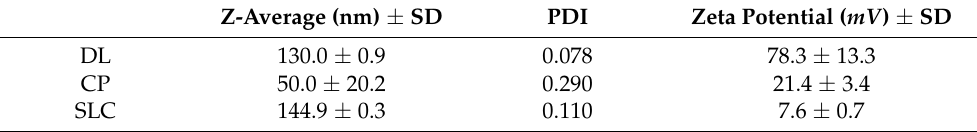
Table 1. Size, size distribution and zeta potential measurements of DL, CP, and SLC.